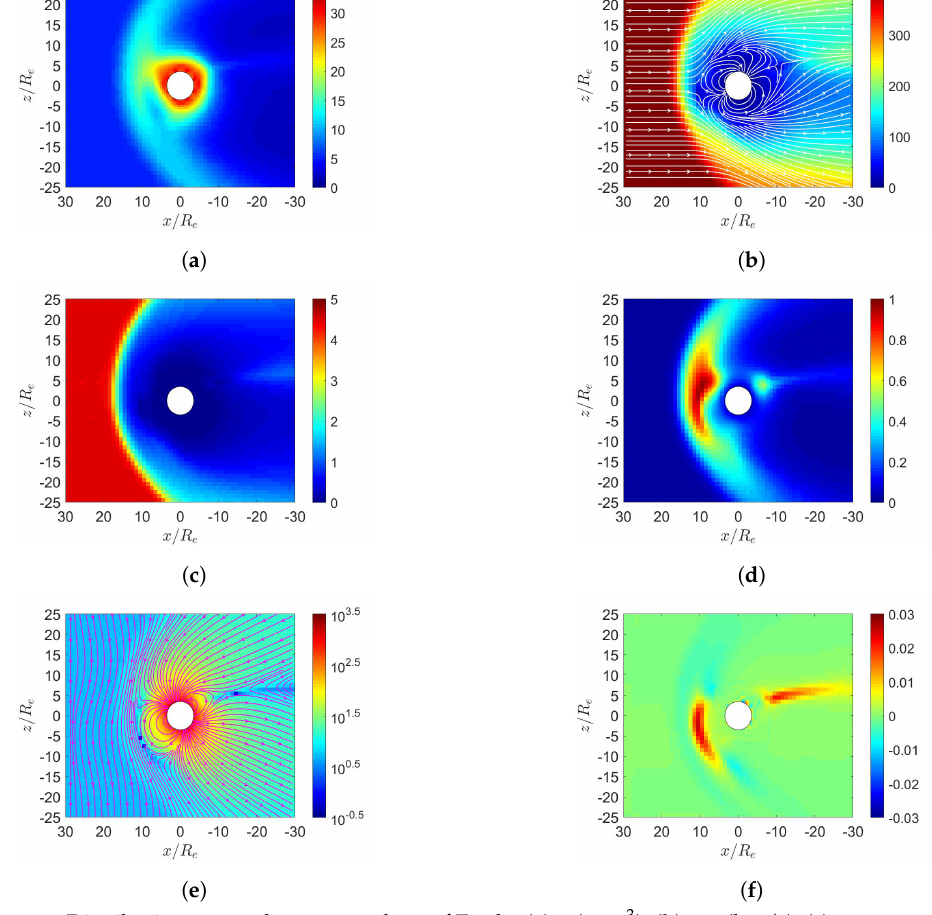
Figure 3. Distributions around magnetosphere of Earth , ( a ) n (cm − 3 ), ( b ) ¯ u xz (km/s), ( c ) magnetosonic Mach number, ( d ) P (nPa), ( e ) ¯ B xz (nT), ( f ) J y ( µ A/m 2 ); southward IMF in June, t = 27 min.